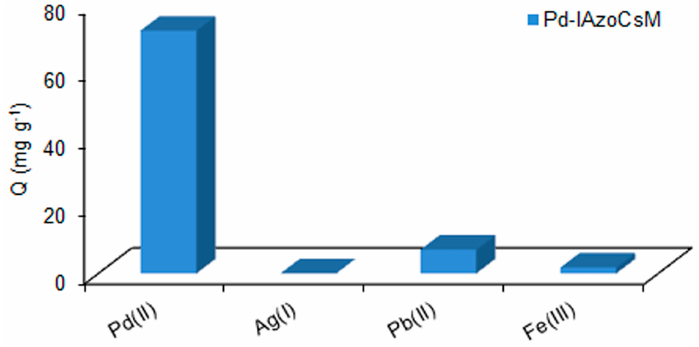
Figure 11. Selective adsorption behaviour of imprinted membrane Pd-IAzoCsM.